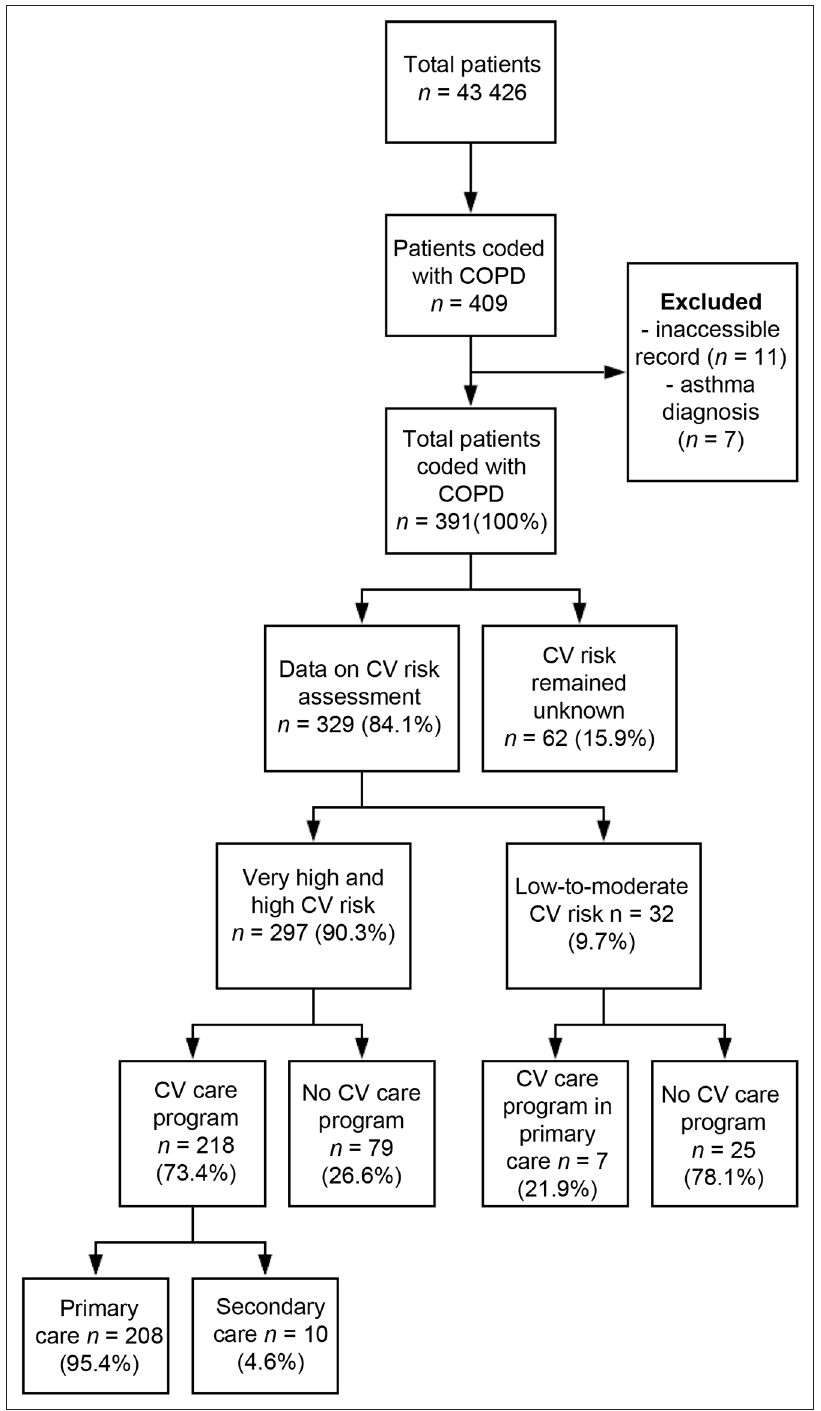
Figure 2 Flowchart: cardiovascular risks and (un)provided cardiovascular care programme. CV =